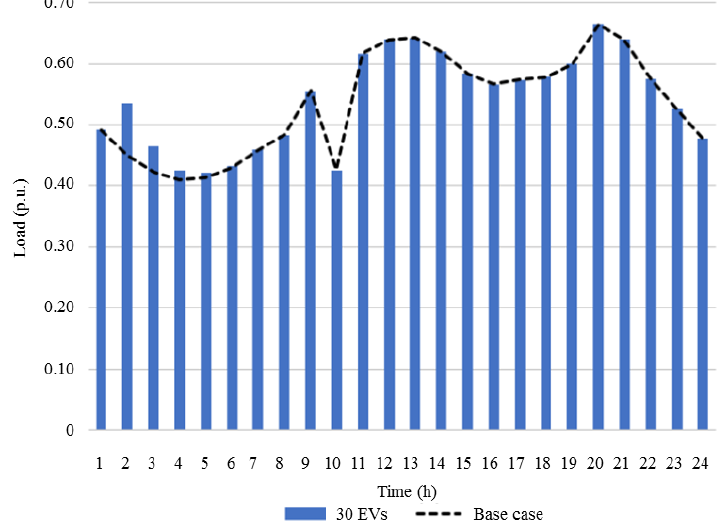
Figure 18. Load demand comparison between the base case and Case 6 (30 EVs, controlled charging).